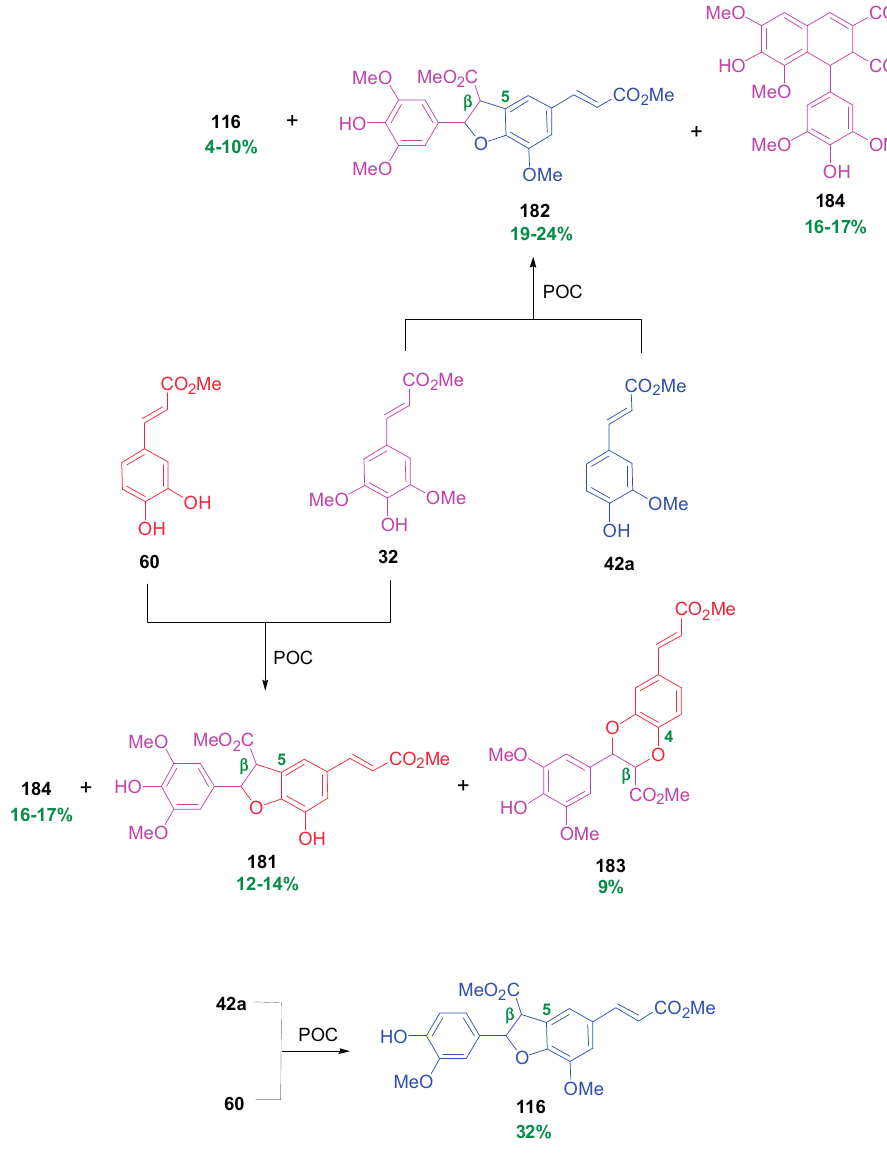
Figure 8. Major dimers obtained from POC of pairs of methyl esters of HCAs using peroxidase-H 2 O 2 or MnO 2 as